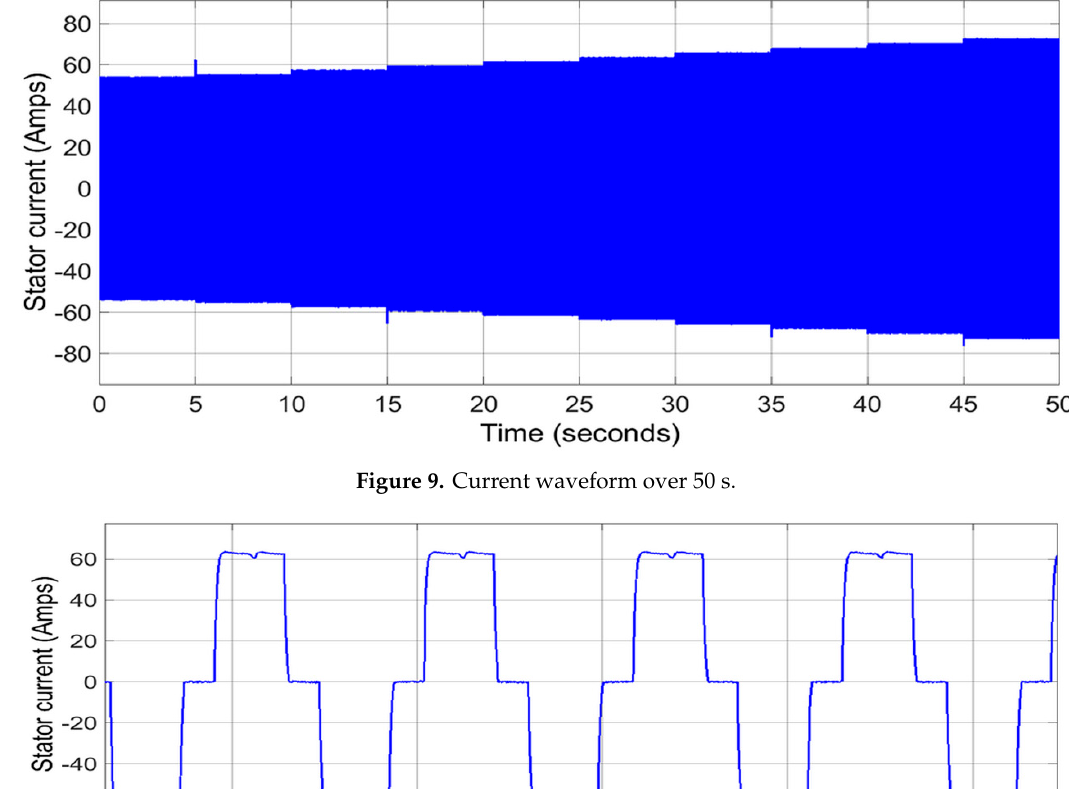
Figure 10. View of the stator’s current waveform.